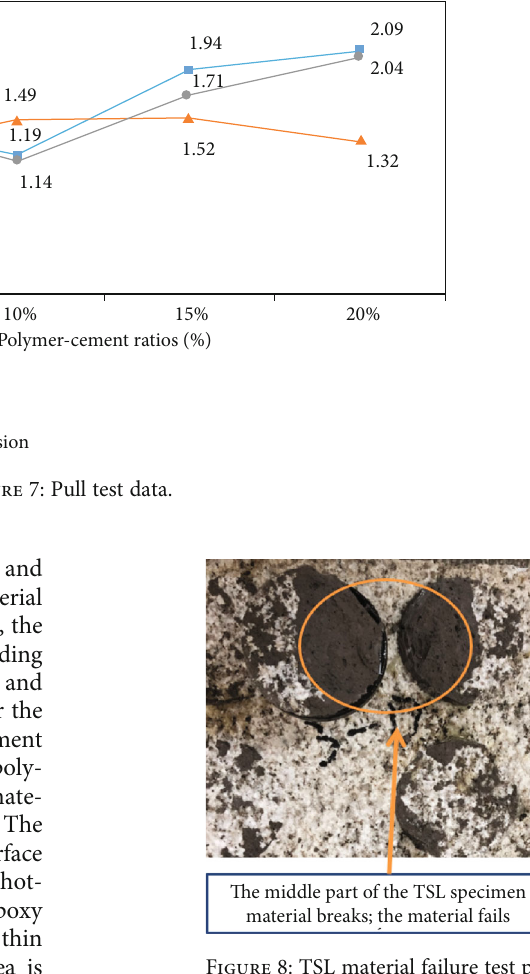
Figure 8: TSL material failure test piece.